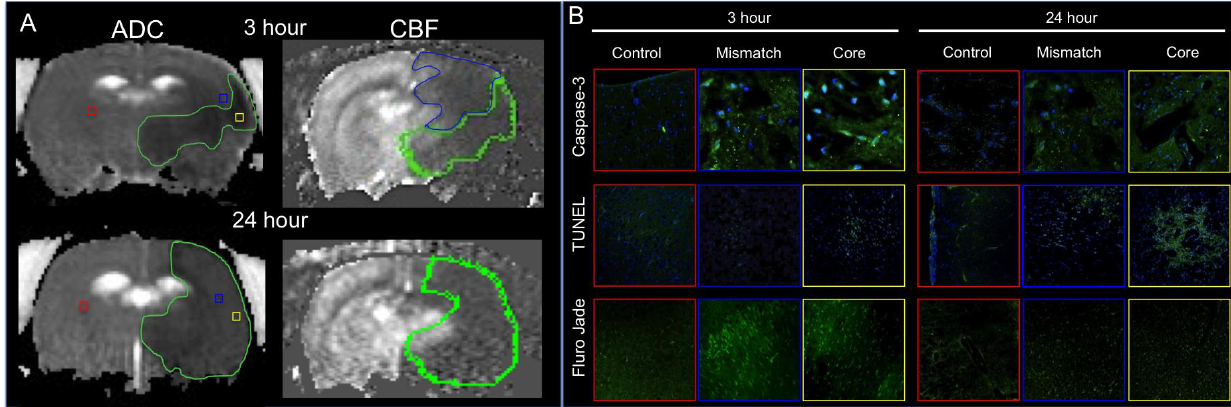
Figure 1. ( A ) Representative Apparent Diffusion Coefficient and Cerebral Blood Flow maps 3 and 24 h post-Middle Cerebral Artery Occlusion. Regions of interest are outlined on the cerebral blood flow map as core (green) and mismatch (blue) with the remaining regions considered healthy. ( B ) Within the selected regions of interest images were collected within the three hour defined regions as core, penumbra and mismatch and are represented by the square boxes of caspase-3, Terminal deoxynucleotidyl transferase dUTP nick end labeling (TUNEL) and Fluro Jade immunostaining. The data demonstrate an increase in caspase-3 expression within the core and penumbra areas compared to healthy tissue and a increase in expression of cell death markers TUNEL and Fluro Jade staining compared to control in the three hour post MCAO animals. By 24 h post-MCAO there is still an increase in caspase, TUNEL and Fluro Jade staining compared to control, however we see less Fluro Jade staining at 24 h compared to the 3 h animals suggesting a loss of